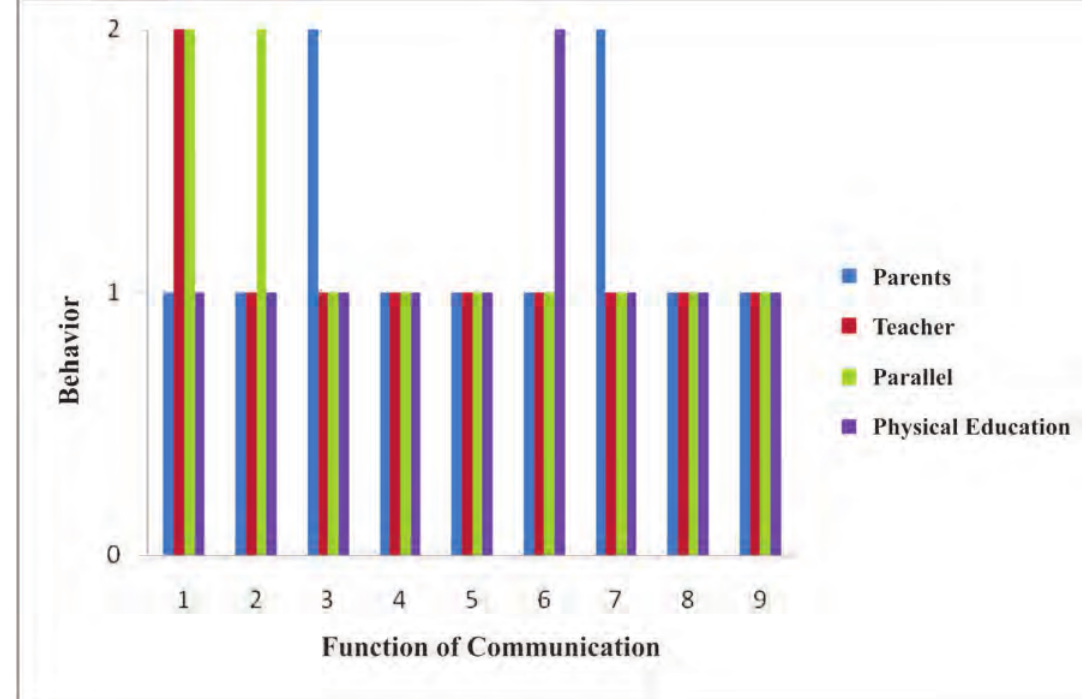
Figure 1. Intention or Function of